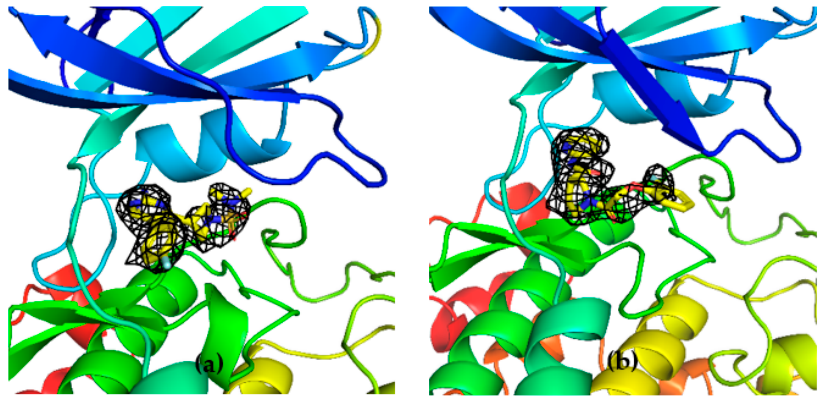
Figure 15. ( a ) 3D structure of GSK-3 β in complex with ARN9133 (PDB 7U33); ( b ) 3D structure of GSK-3 β in complex with ARN1484 (7U36).